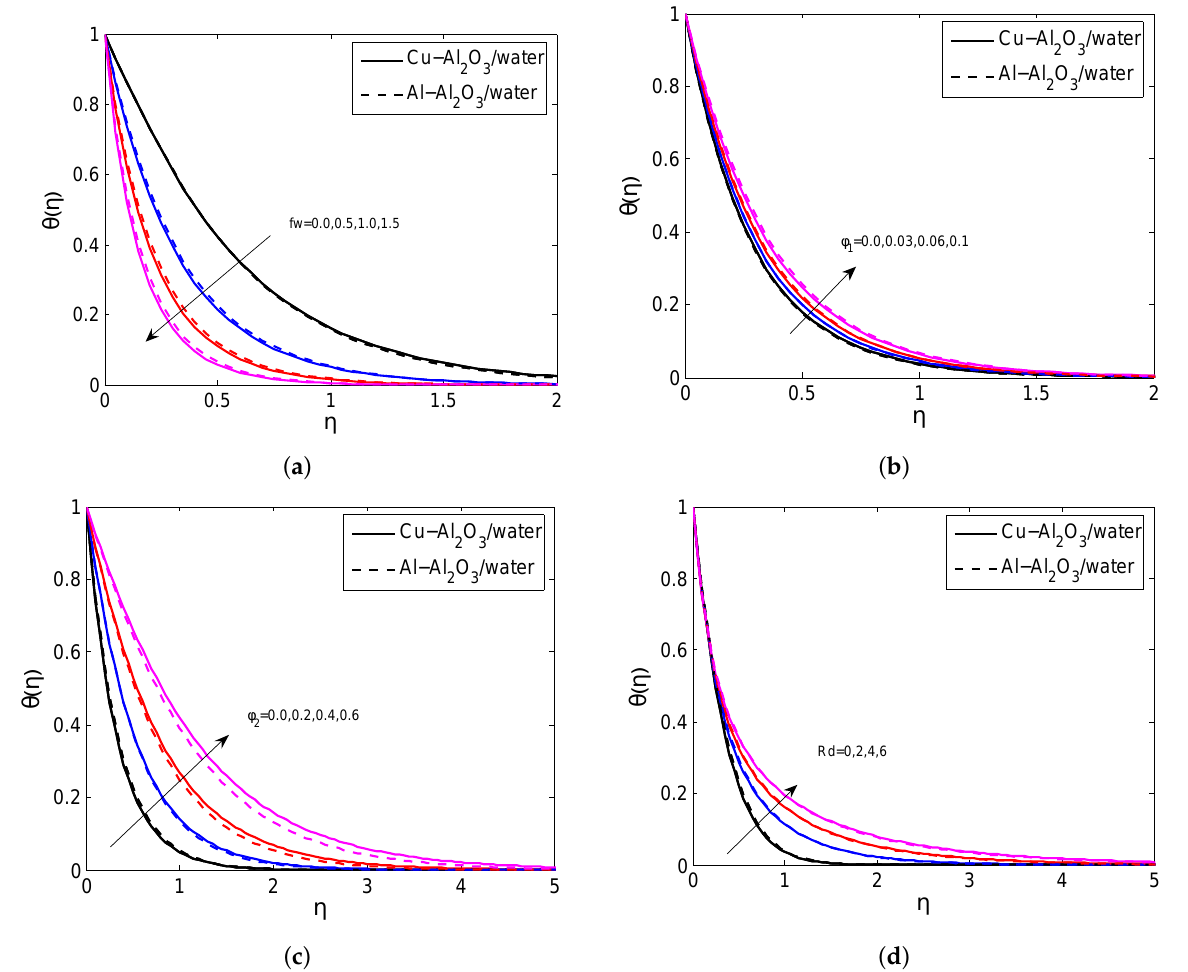
Figure 3. The impact of fw ( a ), φ 1 ( b ), φ 2 ( c ), Rd ( d ) on θ ( η ) for both HNFs.